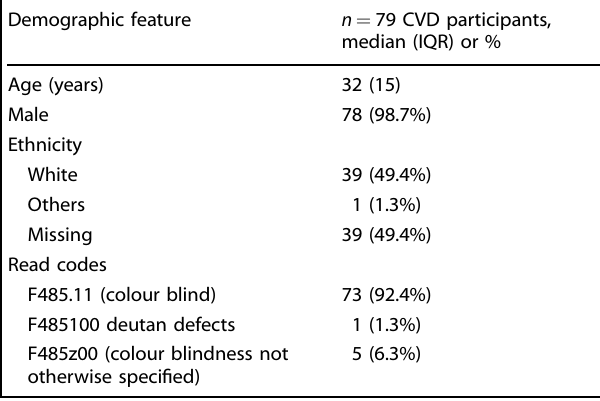
Fig. 1 Bronkotest ® card with the sputum colour chart. 1 and 2 represent white to light yellow classi fi cation of sputum colour and 3, 4 and 5 are increasingly purulent. Table 1. Demographic characteristics of patients diagnosed with CVD from the THIN Database.